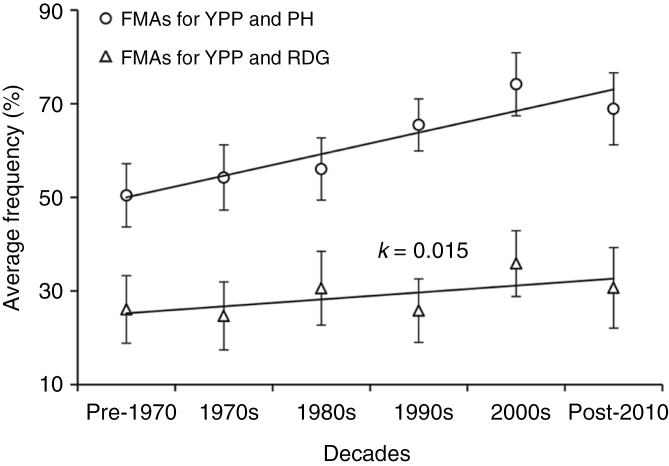
Average frequency of common FMAs associated with YPP and PH, and FMAs associated with YPP and RDG. PH, plant height; YPP, yield per plant; RDG, root depth at mid-grain fill stage; k, the slope of linear regressions.